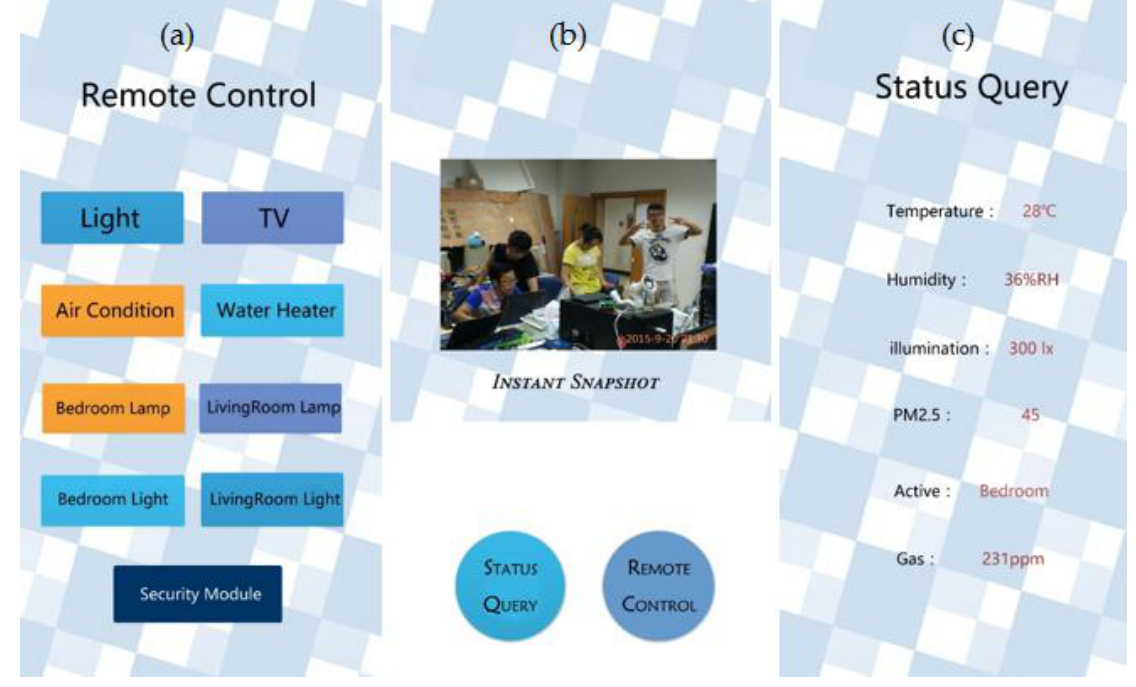
Figure 18. ( a ) Remote control GUI; ( b ) Snapshot camera of front page; ( c ) Status query GUI.